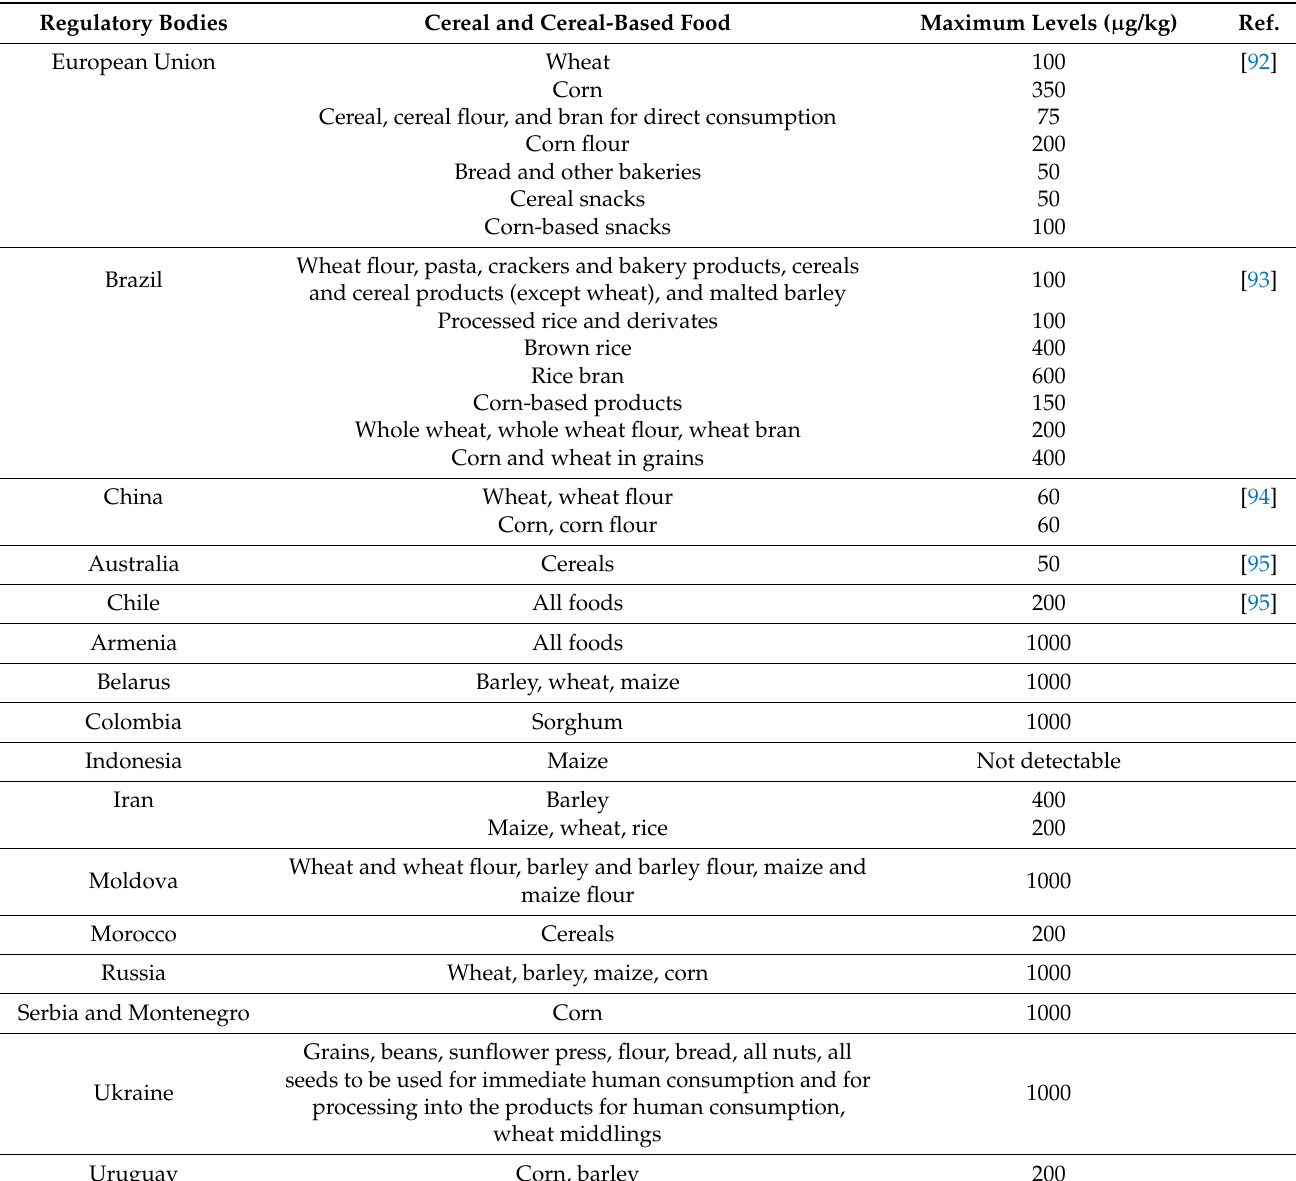
Table 2. Maximum limits for zearalenone in cereals and cereal products in various